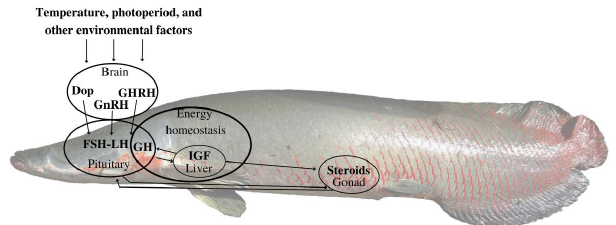
Figure 1. Schematic figure representing the main signaling pathways in the control of fish repro- duction, adapted from Migaud et al. [33]. Environmental information (temperature, photoperiod, etc.), perceived in the brain (pineal, retina, and other receptors) initiates a reproductive cascade regulating the gonadotropin-releasing hormone (GnRH), which initiates the brain–pituitary– gonadal (BPG) cascade. While GnRH release stimulates FSH-LH release, dopamine (Dop) exerts an inhibitory effect. The growth hormone (GH) controlling the insulin-like growth factor (IGF) pro- duction in the liver is believed to be key a messenger in both energy homeostasis and gonadogen- esis through the stimulation of gonadal sex steroids [19].